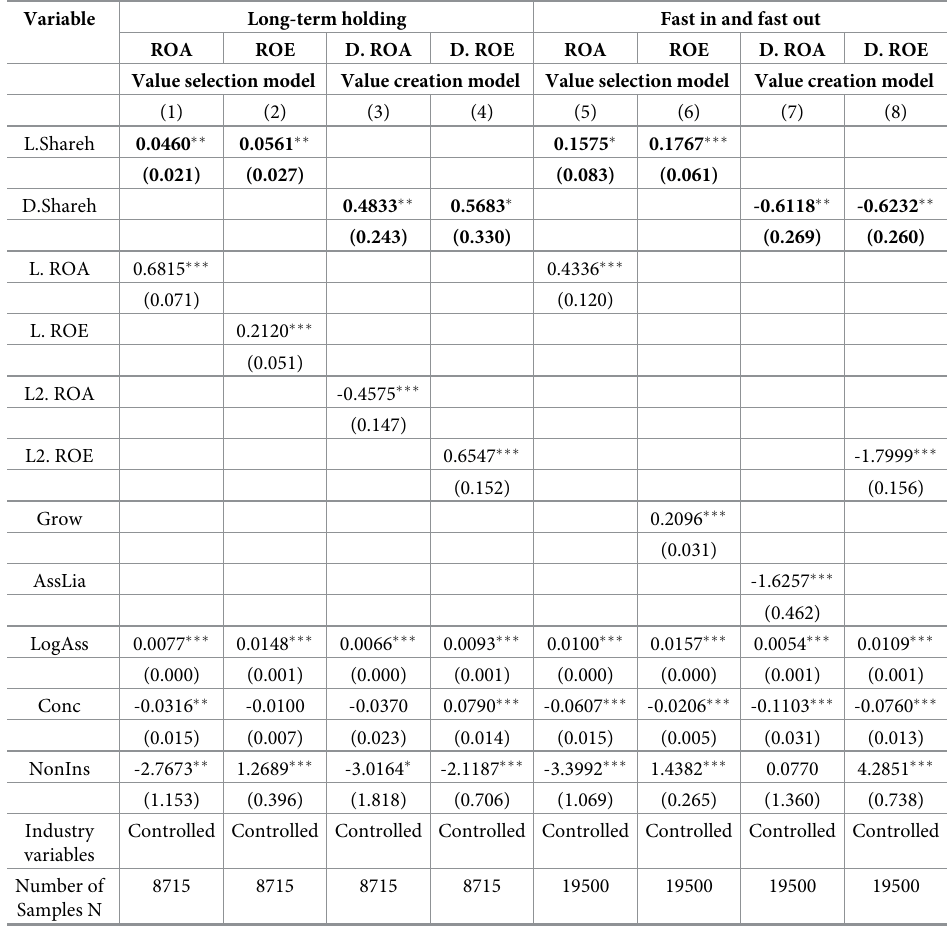
Table 7. Test of alternative